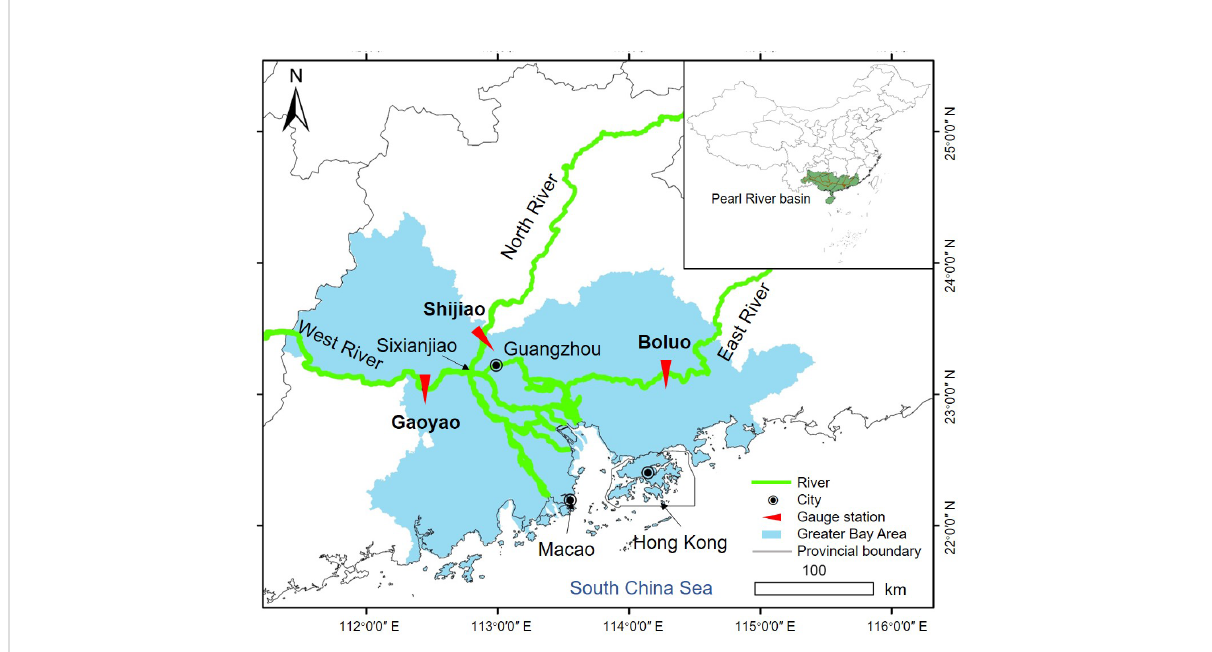
FIGURE 1 Pearl River and the Greater Bay Area, and locations of the three hydrological stations used in this